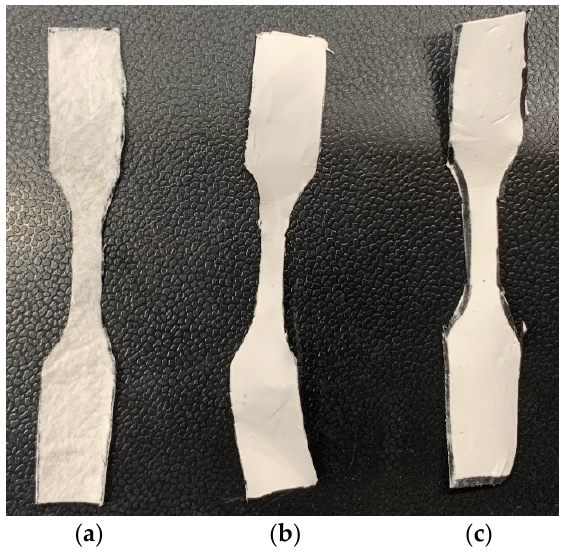
Figure 4. Tension test samples: ( a ) control, ( b ) PCL-3, and ( c ) PCL-10.